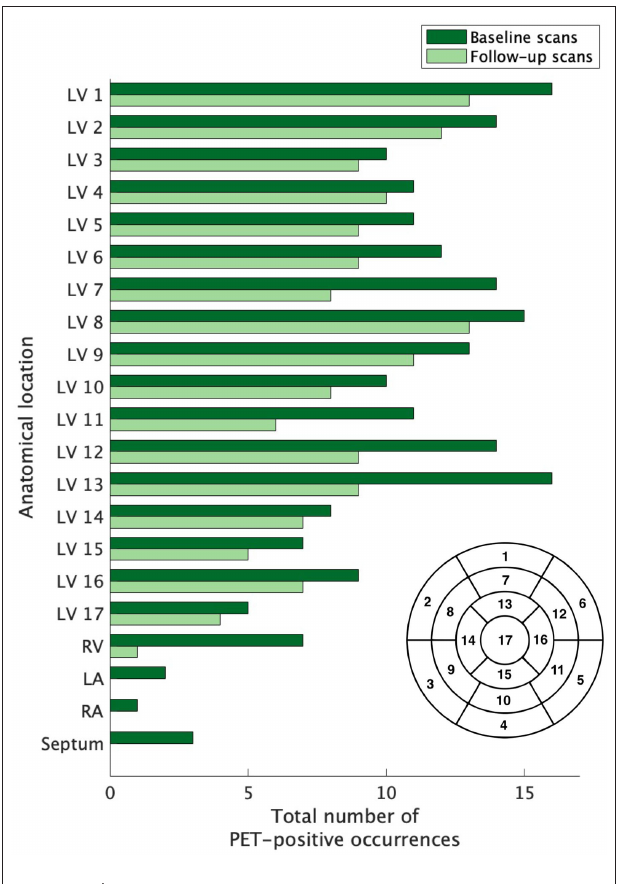
FIGURE 2 | The extent of baseline and recurrent cardiac sarcoidosis. The extent of left ventricle involvement was assessed according to the 17-segment model (lower right of figure) used for grading myocardial damage in ischemic heart disease; the right ventricle, atria, and septum were also evaluated. The extent of active disease for cardiac segments was not equal across compartments. Regions outside of the left ventricle were infrequently affected. Segment 17 was the least commonly affected, but no region of the left ventricle was spared and no region dominated. LV, left ventricle; RV, right ventricle; RA, right atrium; LA, left atrium.